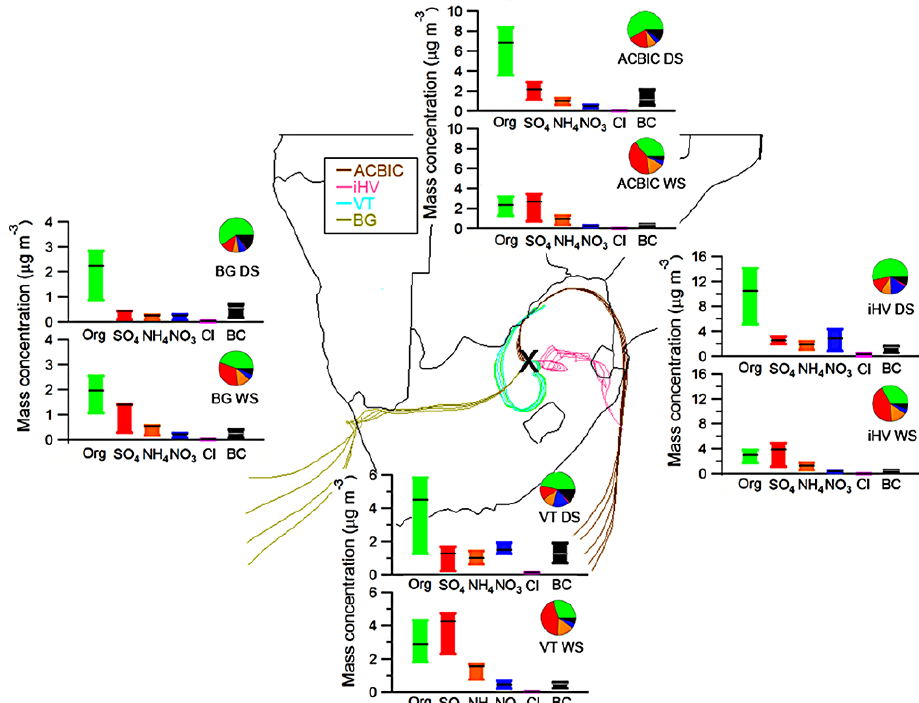
Fig. 7. Summary of NR-PM 1 + BC composition associated with each source region as well as representative 96h backtrajectories marked in colours associated with the source regions. The box plots indicate 25th and 75th percentiles and the line within the box marks the mean. Location of the Welgegund measuring site is marked as a black cross.